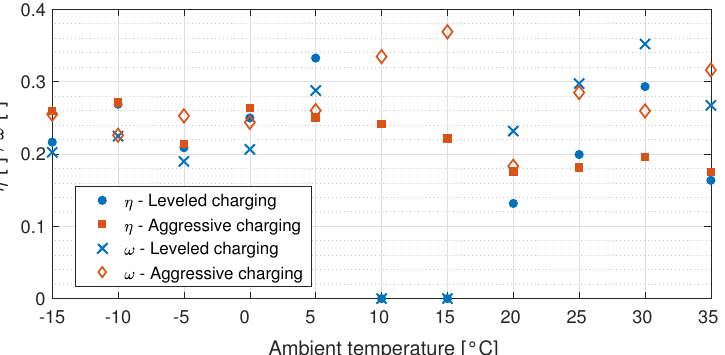
Figure 10. Ejector efficiency ( η ) and entrainment ratio ( ω ) for the EJ design when applying the leveled and aggressive charging